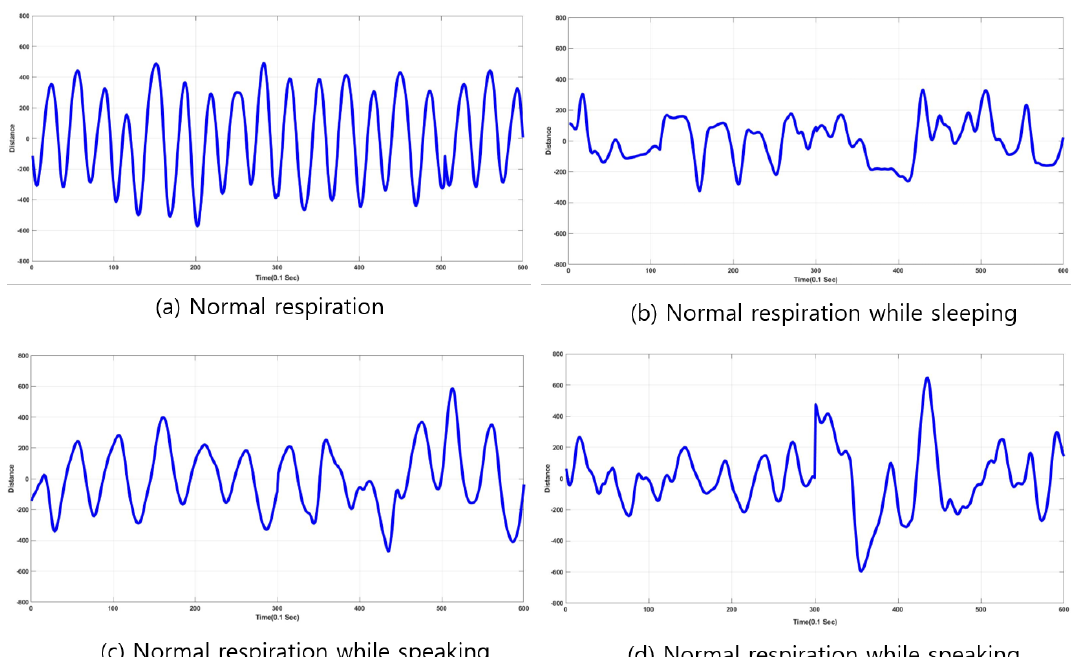
Figure 7. Examples of normal respiration signals. ( a ) Normal respiration in stable environment. ( b ) Normal respiration while sleeping. ( c , d ) Normal respiration while speaking.